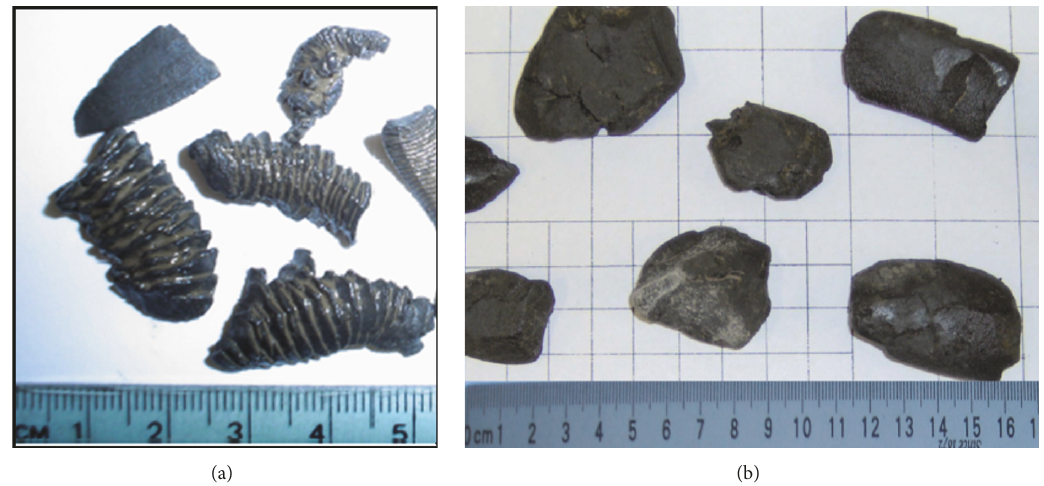
Figure 8: Drilling cuttings. (a) Normal PDC cuttings of shales; (b) blocky cuttings from a formation with preexisting fractures.